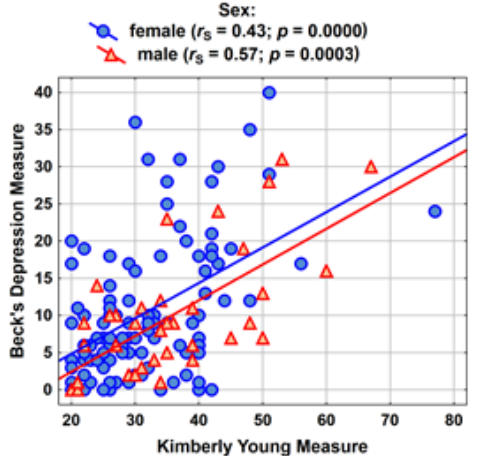
Figure 2. Correlations between intensity of internet use and the measure of